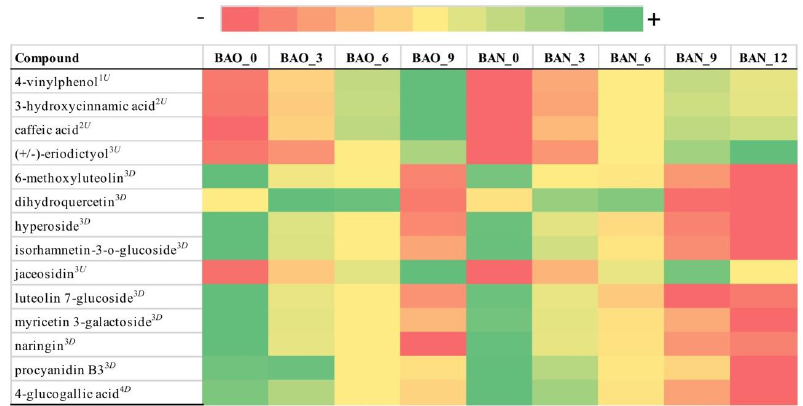
Figure 4. Color coded visualization of Table S3 included in the Supplementary Materials showing the metabolites detected by LC-MS with statistical and practical significance, for cellar FB. Numbers at the end of the sample acronyms represent the sampling month. The color gradient was individualized for each metabolite and the numeric values representing the area of the detected chromatographic peaks after applying variance stabilization are available in Supplementary Table S3. The metabolites can be grouped in the following chemical classes: (1) benzene and substituted derivatives, (2) cinnamic acids and derivatives, (3) flavonoids, and (4) organooxygen compounds. Metabolites that exhibited increasing tendency are indicated as superscript (U) and those with decreasing tendency as superscript (D).